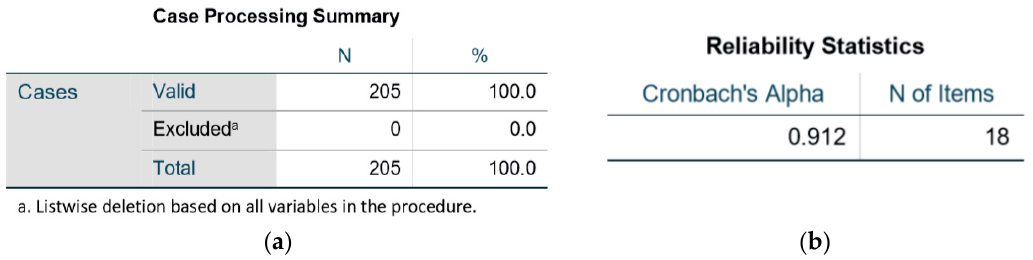
Figure 1. General statistics: ( a ) case-processing summary; ( b ) reliability statistics.